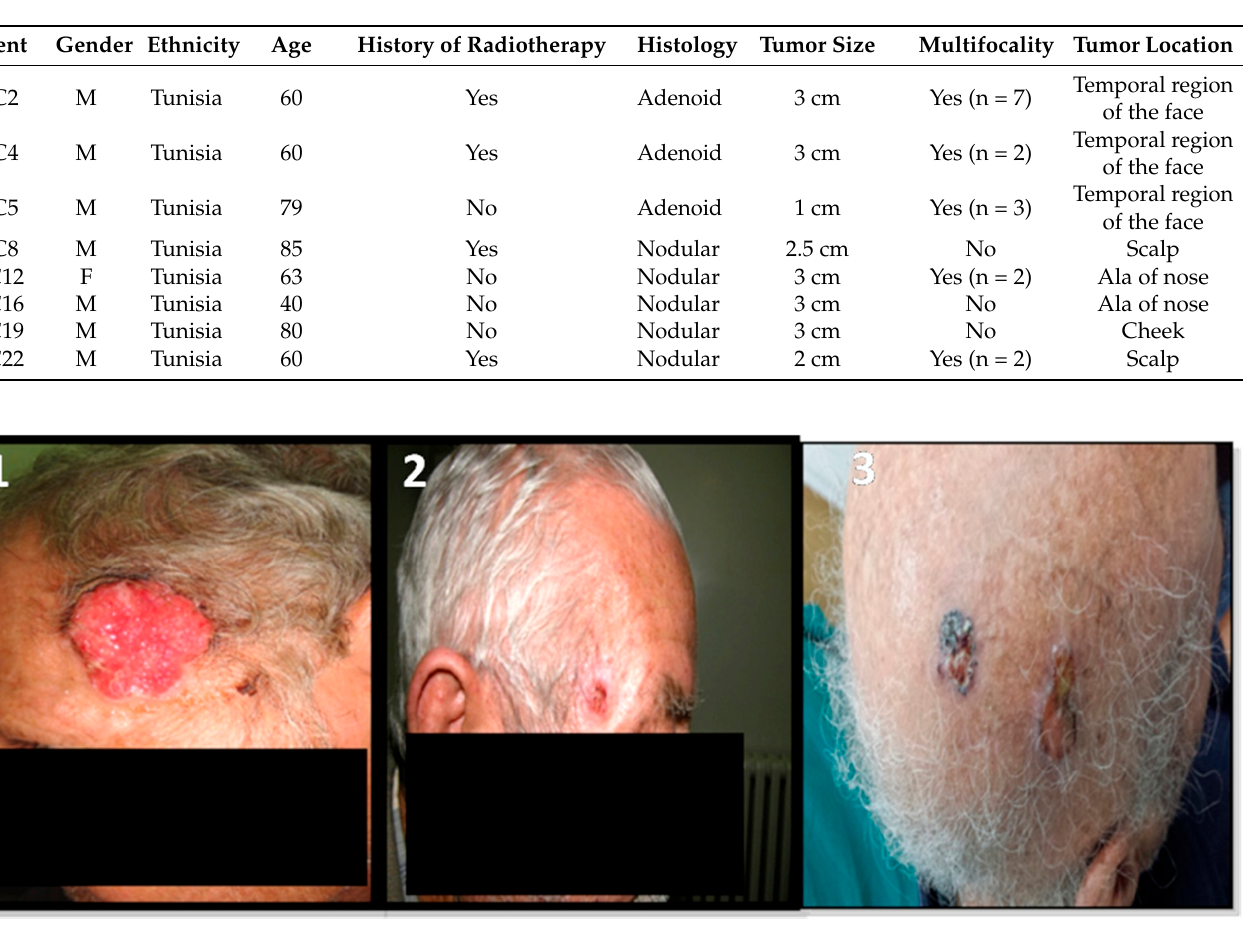
Figure 1. Radio-induced and non-radio-induced BCC patients. 1-corresponds to a non-radio-induced BCC patient. 2,3-correspond to two radio-induced patients: 2-presents one small malignant lesion; 3-presents multiple lesions on the scalp. The aggressive form of BCC is independent of radiation etiology in this